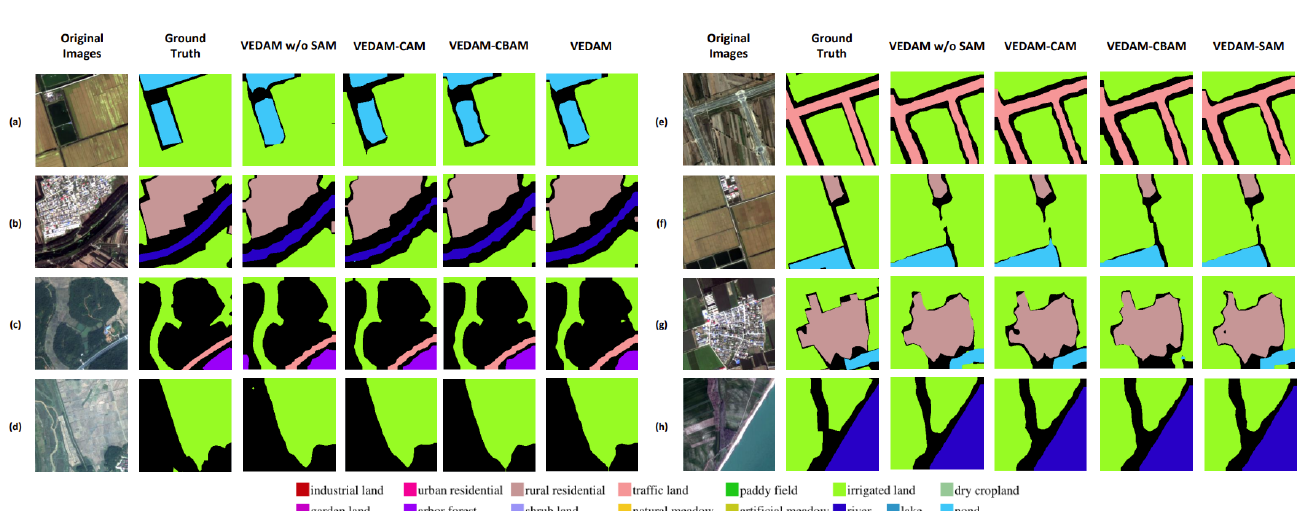
Figure 9. Visualization of segmentation results of VEDAM combined with different attention mod- ules on the GID dataset, ( a – h ) represents the visualization results of randomly selected